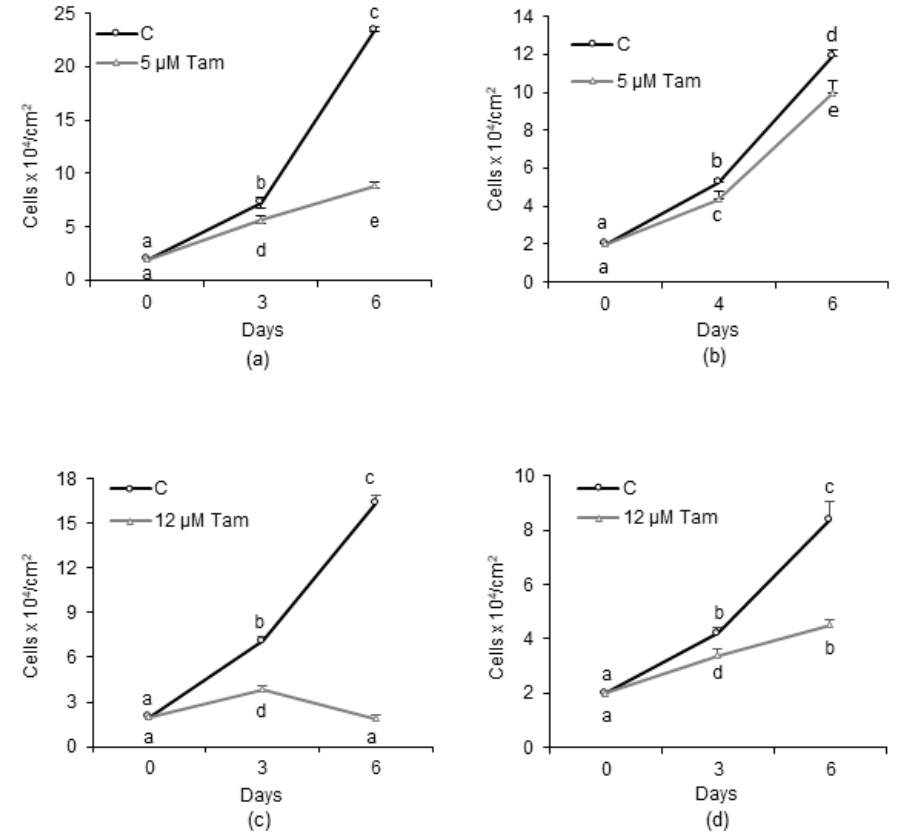
Figure 1. Effect of tamoxifen (Tam) on growth of human breast cancer cell lines. ( a , b ) Growth of MCF7 and MCF7-TamR cells, respectively, in the absence or presence of 5 µM Tam. ( c ) Growth of MCF7 and MCF7-TamR cells ( d ) in the presence of 12 µM Tam, which represents the calculated IC 50 for Tam for the parental cell line. Data represent the mean ± SD of at least three independent experiments. Different letters indicate statistically different means as determined by ANOVA followed by a Student–Newman–Keuls post hoc test; statistical significance was set at p < 0.05.